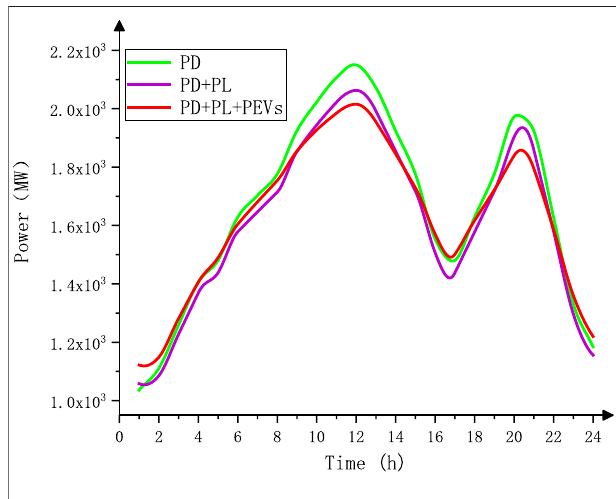
FIGURE 6 | The demand considering the loss and PEVs for Case VI